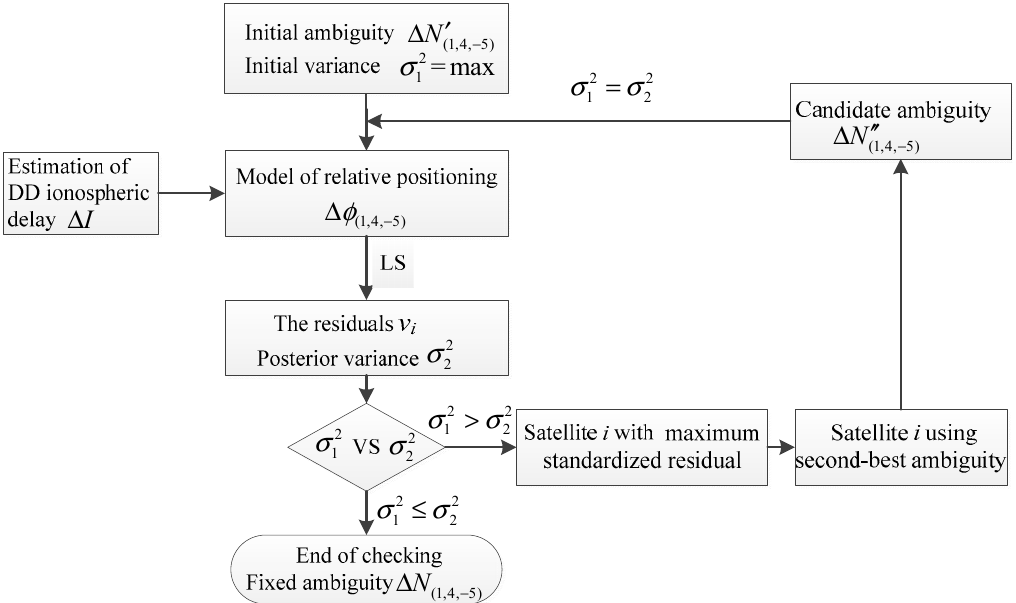
Δ . LS: Least-squares N − (1,4, 5)